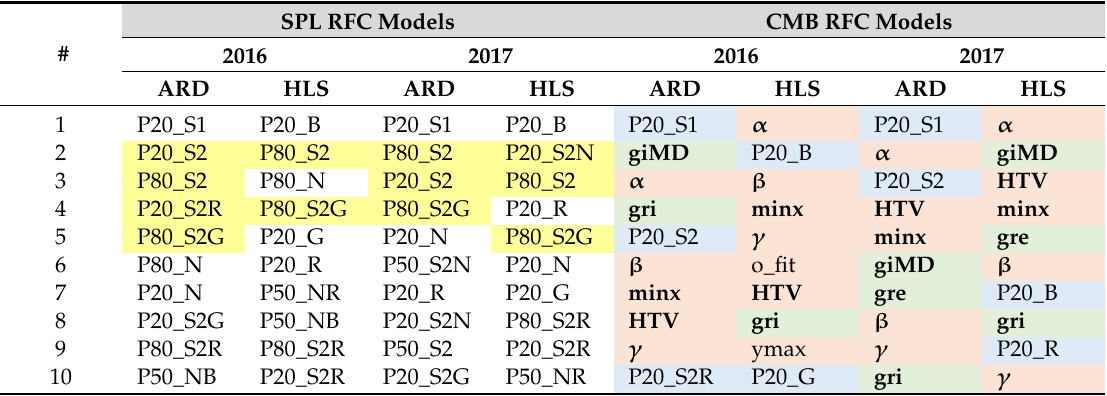
Table 10. Top 10 important variables of SPL and CMB RFC models. In the SPL RFC models, spectral variables in the top 5 that involved SWIR-2 bands are highlighted in light yellow . In the CMB RFC models, spectral variables are highlighted in light blue and phenometrics from the CxQ and HPLM are highlighted in light orange and light green , respectively. Bolded items are variables related to the initial green-up phase of the seasonal growth.